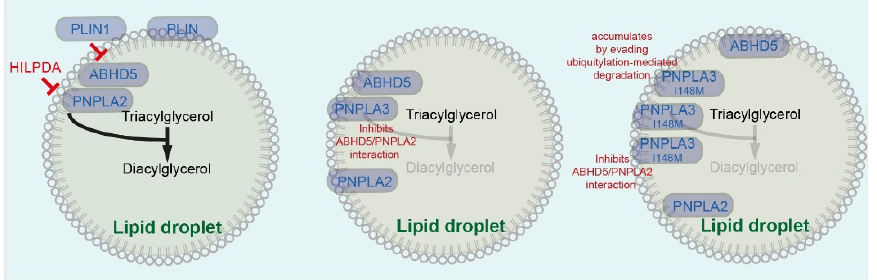
Figure 2. Lipid droplet-associated factors involved in lipolysis. PNPLA3 I148M variants sequesters ABHD5 that limits access to PNPLA2 and attenuates PNPLA2-mediated lipolysis. ABHD: Alpha beta hydrolase domain, HILPDA: Hypoxia-inducible LD associated, PLIN: Perilipin, PNPLA: Patatin-like phospholipase domain-containing.